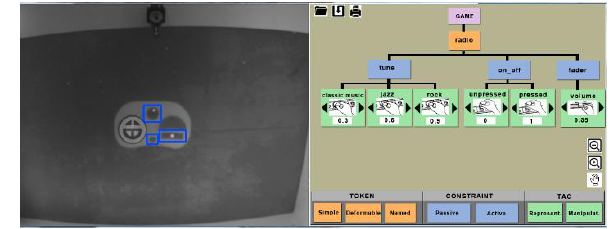
FIGURE 8. ToyVision graphic